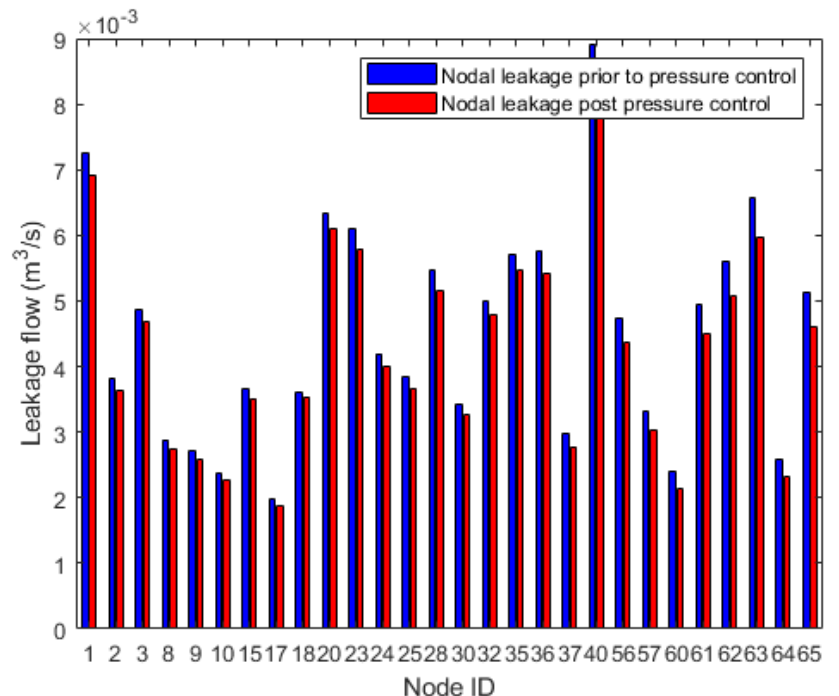
Figure 6. Nodal leakages prior to and post pressure